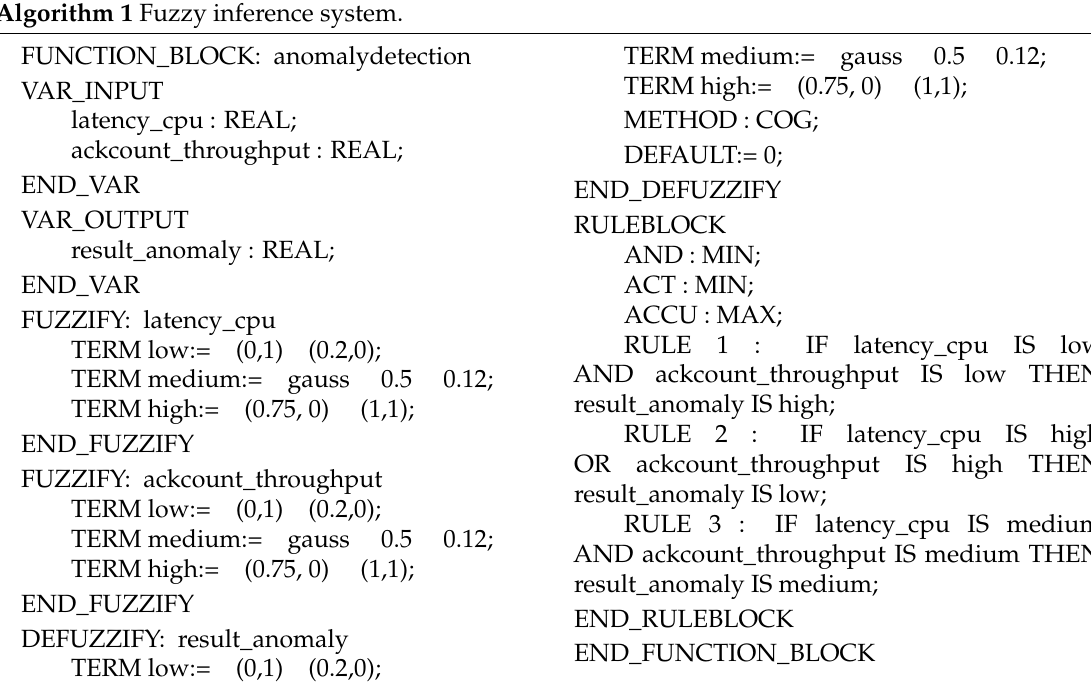
Algorithm 1 Fuzzy inference